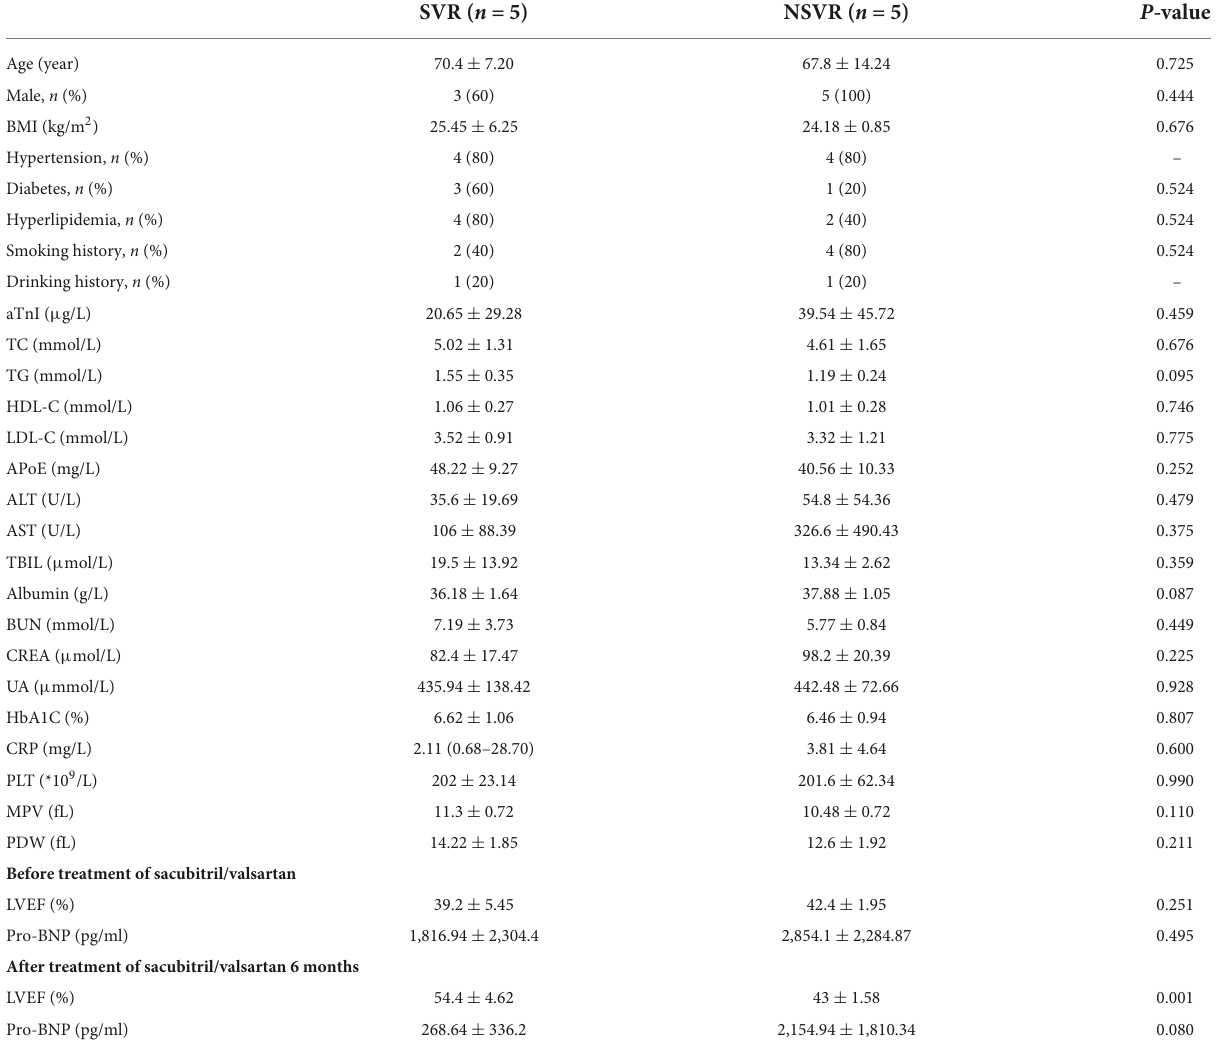
TABLE 2 The clinical characteristics of the SVR and NSVR patients included in tsRNA expression profile